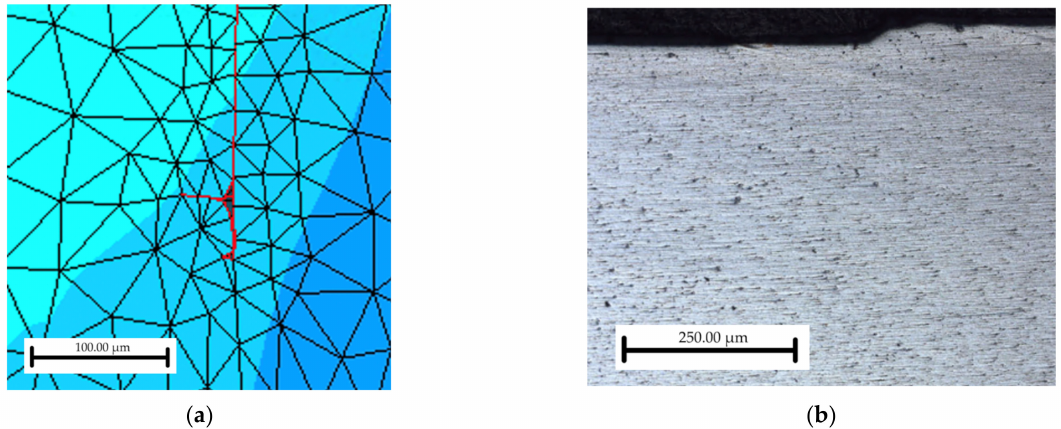
Figure 16. A visualization of the lack of a void in the material caused by non-volumetric kinematics. ( a ) The lack of a void in the model; ( b ) The lack of a void in the welding